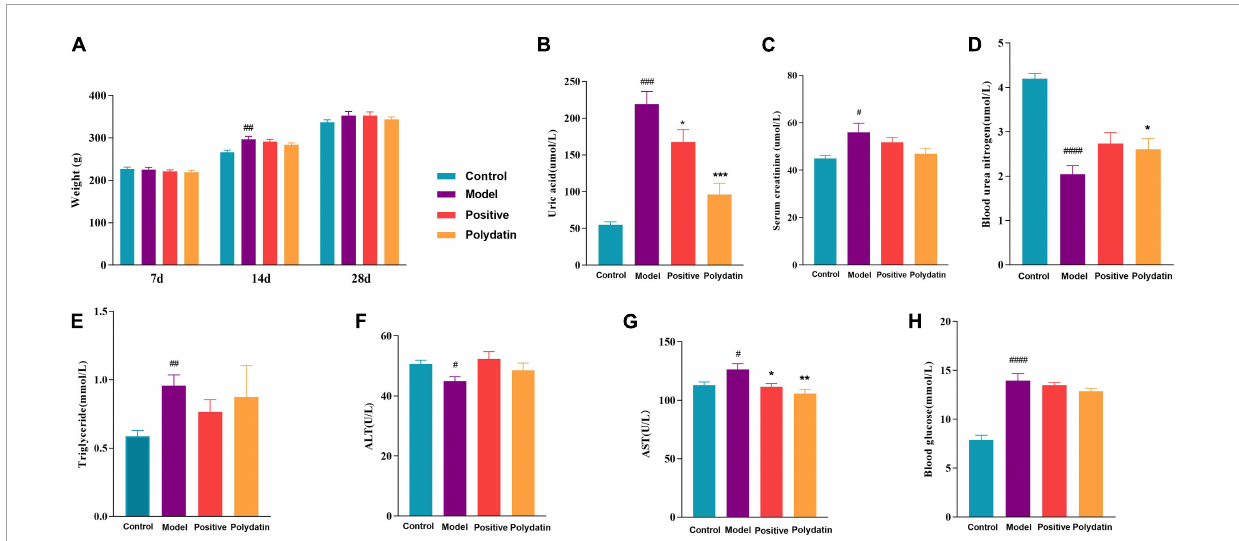
FIGURE1 Effects of polydatin on biochemical indicators in serum from HUA rats. (A) Weight change of rats in 28 days. (B) Serum uric acid (SUA). (C) Serum creatinine (Scr). (D) Blood urea nitrogen (BUN). (E) Serum triglyceride (TG). (F) Alanine transaminase (ALT). (G) Aspartate aminotransferase (AST). (H) Blood glucose. Values are given as the mean ± SEM ( n = 8) ( ∗ p < 0.05, ∗∗ p < 0.01, ∗∗∗ p < 0.001, vs. model group; # p < 0.05, ## p < 0.01, ### p < 0.001, #### p < 0.0001, vs. control